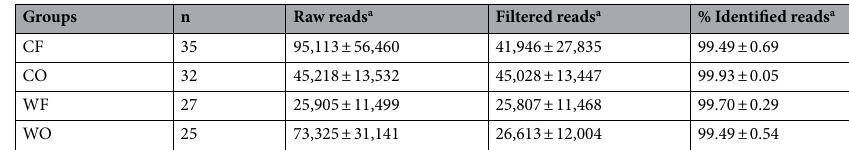
Table 2. Sequencing and reads classification summary. The abbreviation represented the macaque groups and sample types including, CF captive-fecal, CO captive-oral, WF wild-fecal, and WO wild-oral. a Number of reads (mean ±